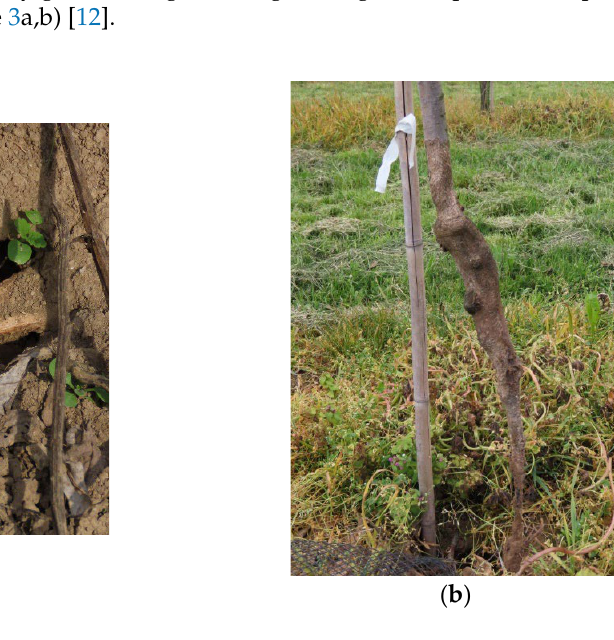
Figure 3. Damage of trees in orchards by bark gnawing in 2019–2020: ( a ) Damage of trunk, and rootstocks by common vole ( Microtus arvalis ) (Brno, 2019); ( b ) damage of trunk and roots by water vole ( Arvicola amphibius ) (Holovousy, 2020). © Josef Suchomel. Water voles usually exhibit eight- to ten-year population cycles, which operate inde- pendently from the dominant Microtus sp. and bank vole cycles (for example, in northern Europe [29,30]), but in 2019 and 2020 synchronization with the common vole population was